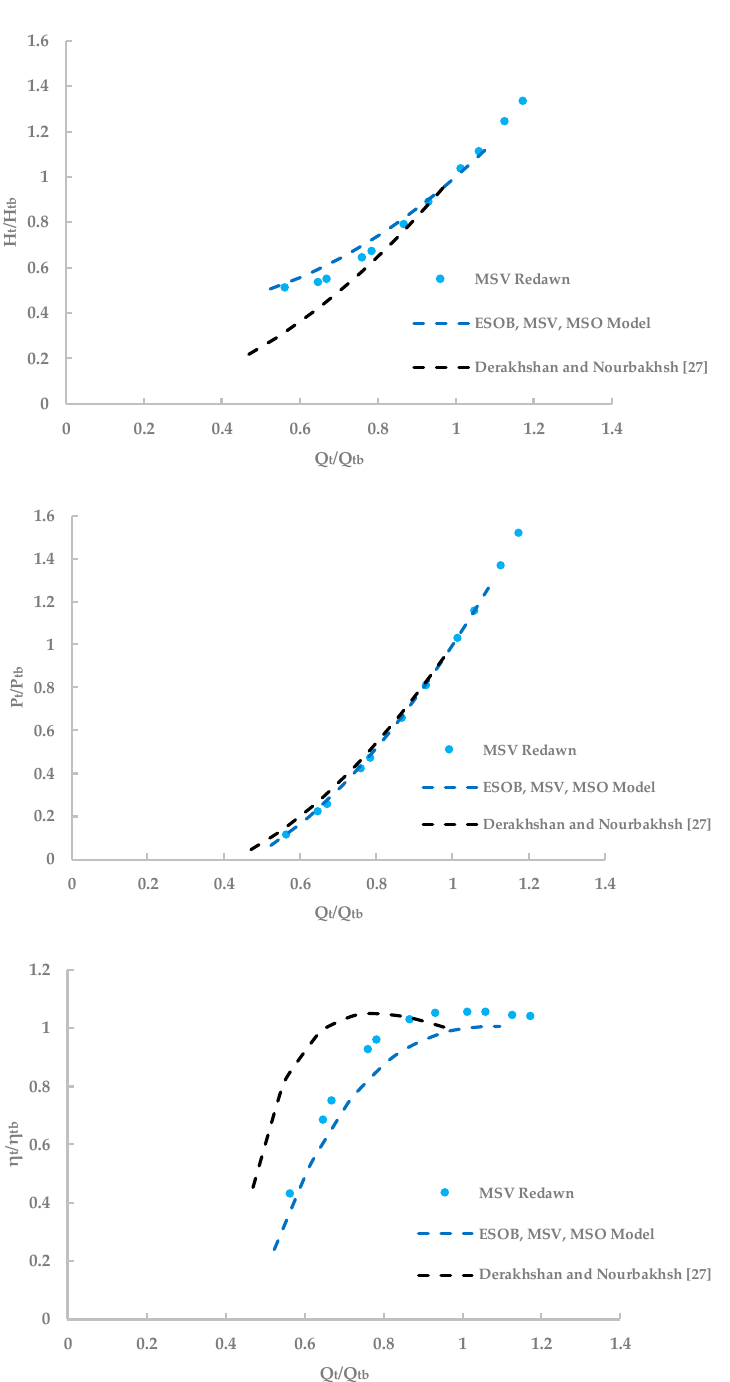
Figure 9. Characteristic curves for the 92SV2G150T_IE3 MSV pump. Experimental data (dots), proposed model (blue dashed line), and Derakhshan and Nourbakhsh [27] model (black dashed line): head-discharge ( upper panel), power-discharge ( central panel), and efficiency-discharge ( lower panel).